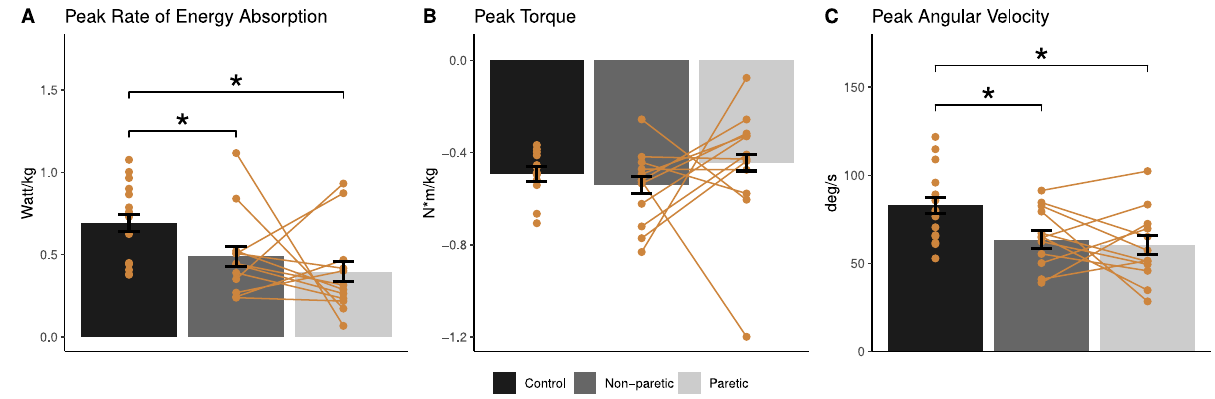
Figure 4. Between-group comparison of ankle joint kinetics and kinematics (mean ± standard error). Negative value indicates ankle plantarflexion in torque ( B ) and angular velocity ( C ). Yellow points show data from individual participants, and data from the same participant are linked with yellow lines. *p < 0.05, **p < 0.01.